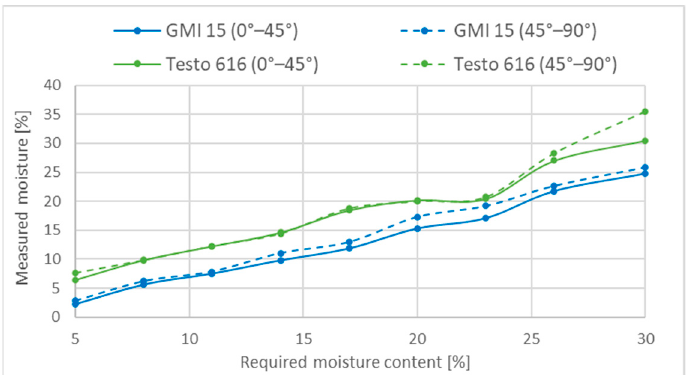
Figure 12. Comparison of the measured values of the moisture meters (GMI 15, Testo 616) on the MC of softwood (S—spruce) in the transverse direction in the moisture range of 5 to 30% with re- spect to the ring deflection in the range of 0°–45° (radial) and 45°–90° (tangential).